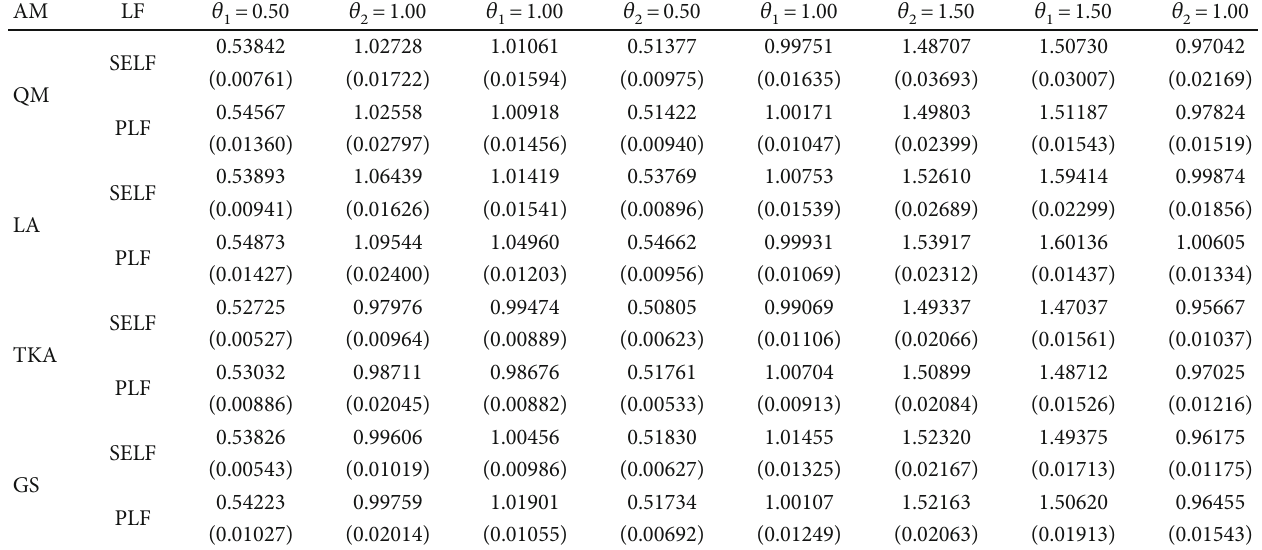
Table 8: BEs and PRs (in parentheses) under IP for